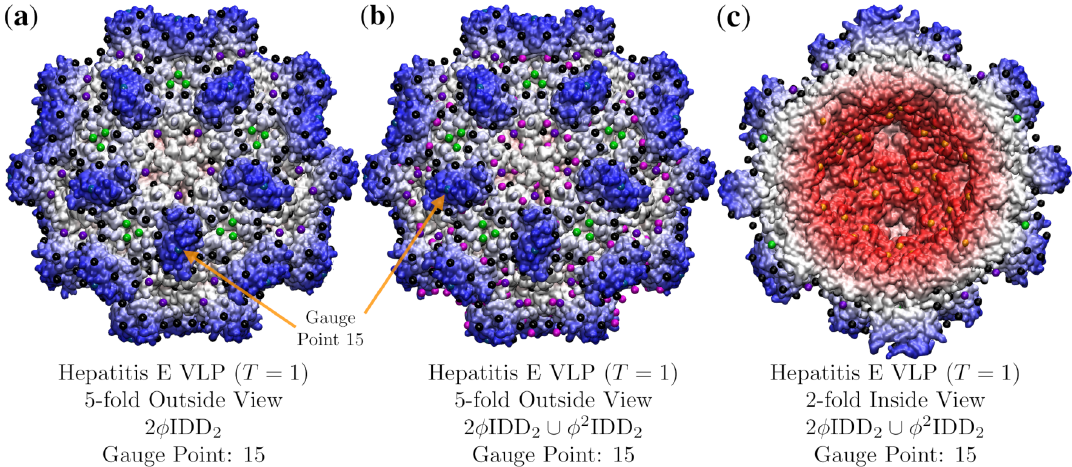
Figure 13. A demonstration of how point array fits may be improved using double base point arrays. In ( a ) we see T = 1 Hepatitis E virus-like particle ( T = 1, 3hag [19]) fitted only by 2 φ IDD 2 with an RMSD of 3.2 Å and Gauge Point 15. This point array however does not have any points on the interior surface of the capsid. In ( b ) we combine 2 φ IDD 2 with the smaller radius point array φ 2 IDD 2 , shown here as magenta points, irrespective of their geometric locations deviating from Table 1. These new points sit perfectly on the surface and add interior surface locations and lower the RMSD to 2.8 Å. In ( c ) we see the interior of our capsid, φ 2 IDD 2 shown in orange along the 5-2 great circle. The point array fitting of the capsid interior can also be seen in Figure 14.